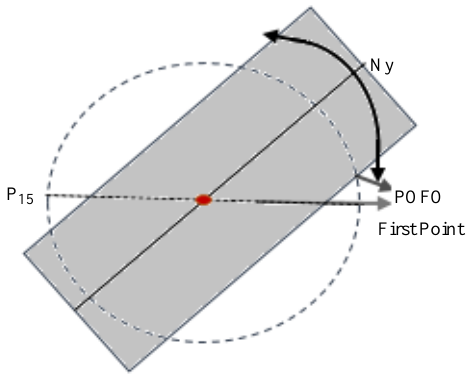
Figure 4. An example of extracting local vessel pattern for R = 15 and N = 96 and estimation of POFO and N v . Value of white circle is one (for vessel points) and black circle is zero (for non-vessel